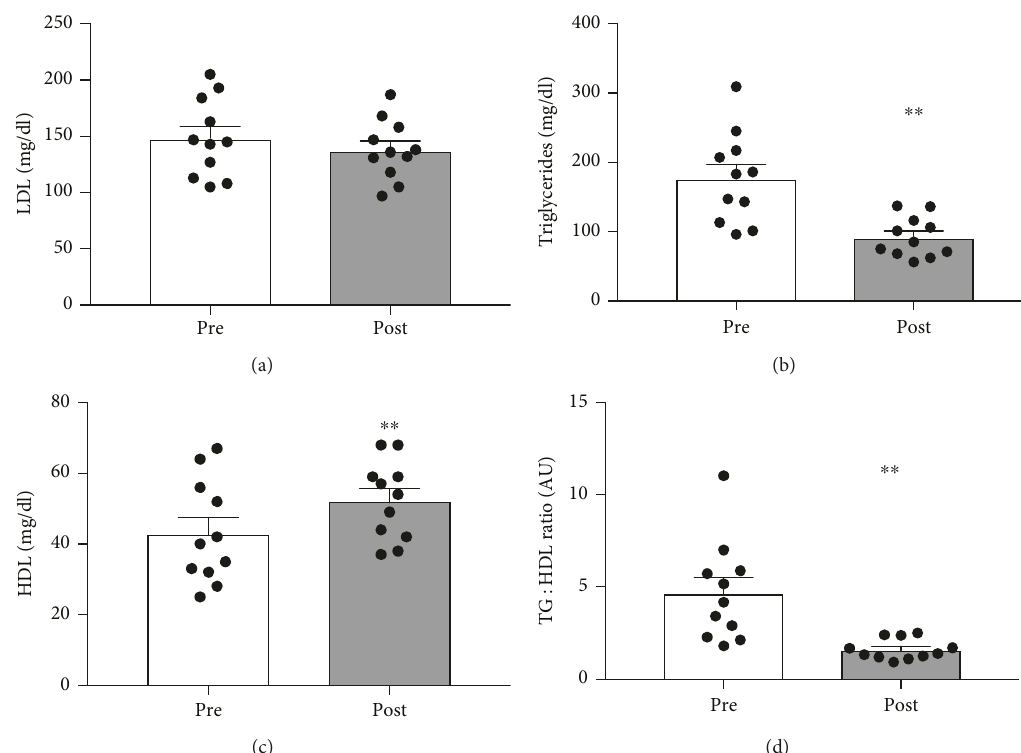
Figure 4: The e ff ect of a 90-day low-carbohydrate diet on LDL cholesterol (a), triglycerides (b), HDL cholesterol (c), and TG: HDL ratio (d) in women ( n = 11 ; ∗ p < 0 05 ).